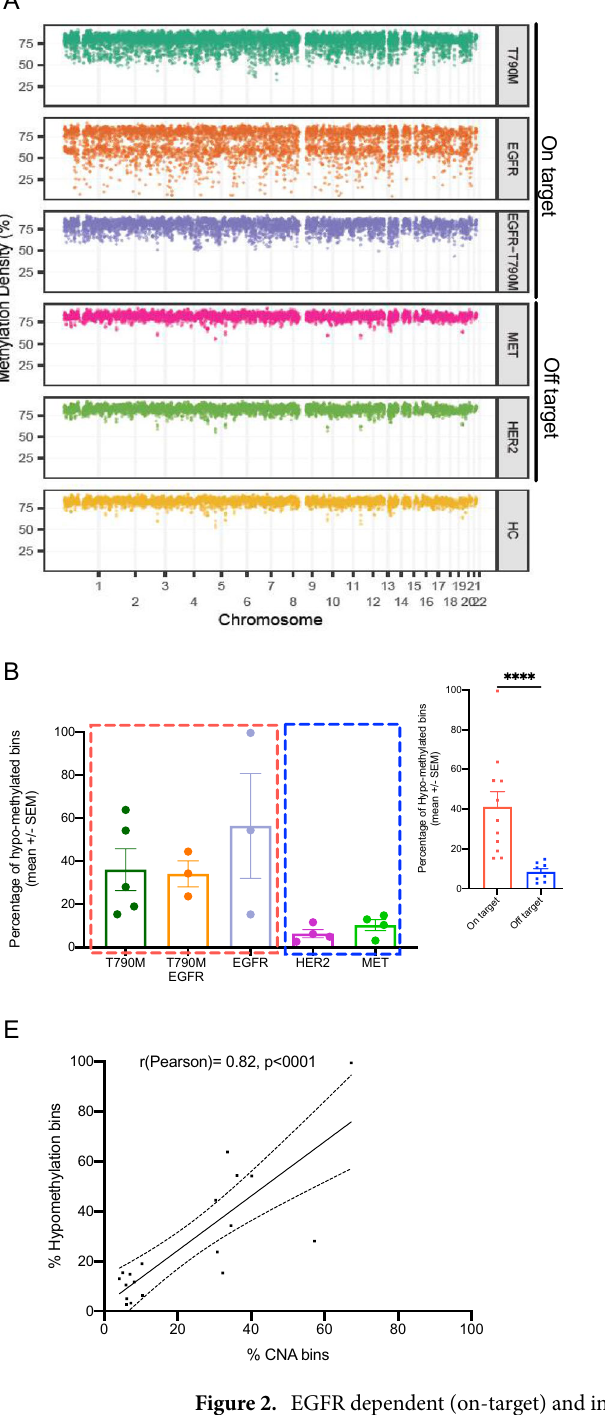
Figure 2. EGFR dependent (on-target) and independent (off-target) resistance mechanisms showed distinct landscapes of genome-wide methylation and copy number changes. ( A , C ) Methylation density (MD) ( A ) and DNA copy number ( C ) alterations for each 1 Mb bin along the chromosomes (chr1-22). Cases with T790M (n = 5), EGFR amplification (n = 3) and T790M and EGFR amplification co-occurrence (n = 3) were grouped into the on-target group while HER2 amplification (n = 4) and MET amplification (n = 4) cases were grouped into the off-target group. Healthy individuals (n = 20) were used as a reference group to determine the baseline levels of MD and CNA. ( B , D ) Percent of hypo-methylated bins ( B ) and CNA bins ( D ) in cases with different resistance mutation profiles grouped into the on-target group or the off-target group. The component bar graphs showed the comparison between the two groups. Data are shown as mean ± SEM. **p < 0.01, ****p < 0.0001 (Mann– Whitney test). ( E ) Linear regression and Pearson’s correlation between proportion of hypo-methylated bins and CNA bins in 19 patients from both on-target and off-target